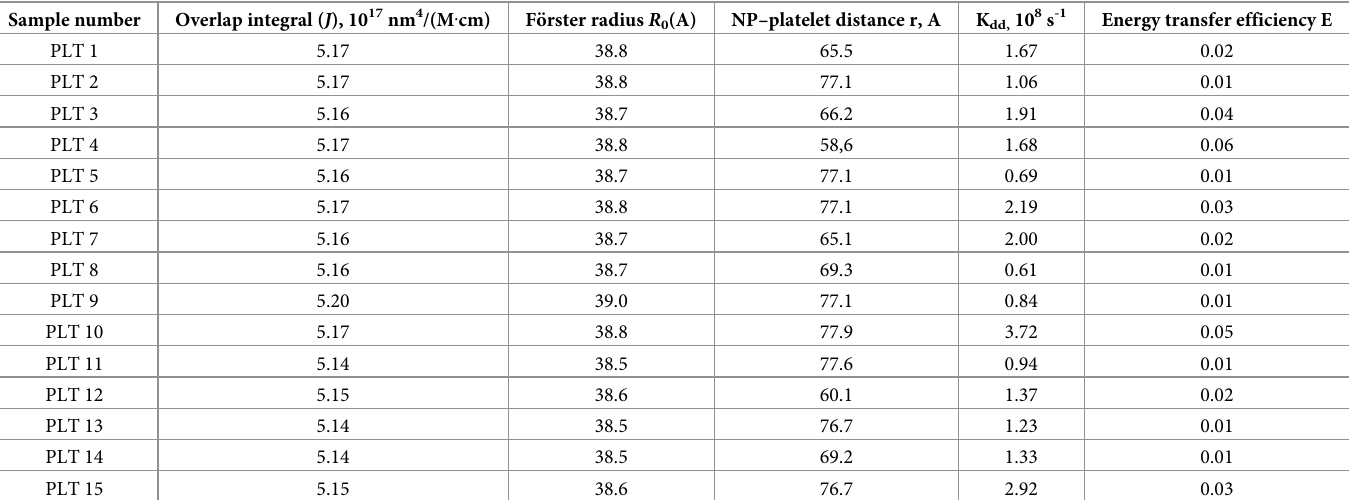
Table 3. Calculated FRET parameters. Sample